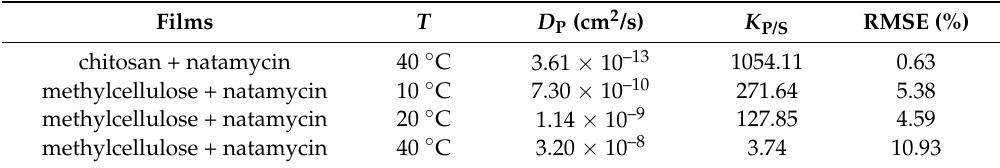
Table 1. Partition ( K P/S ) and apparent diffusion ( D P ) coefficients (mean values) of natamycin from the active films in food simulant at different temperatures ( T ).